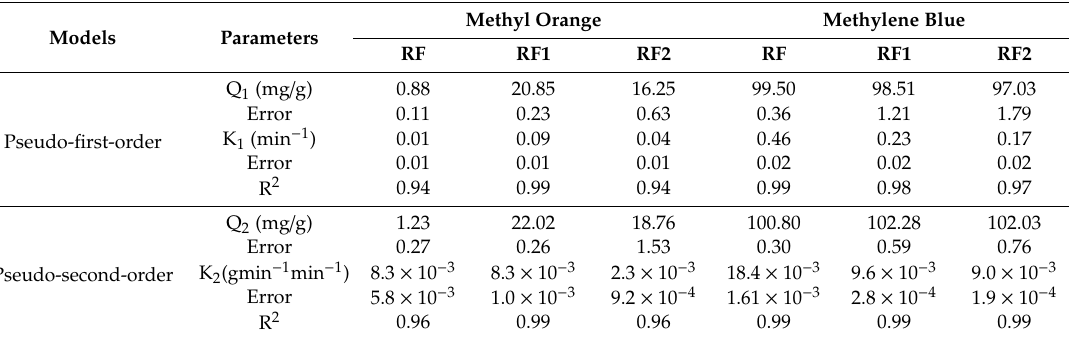
Table 4. Kinetic parameters of MO and MB adsorption.